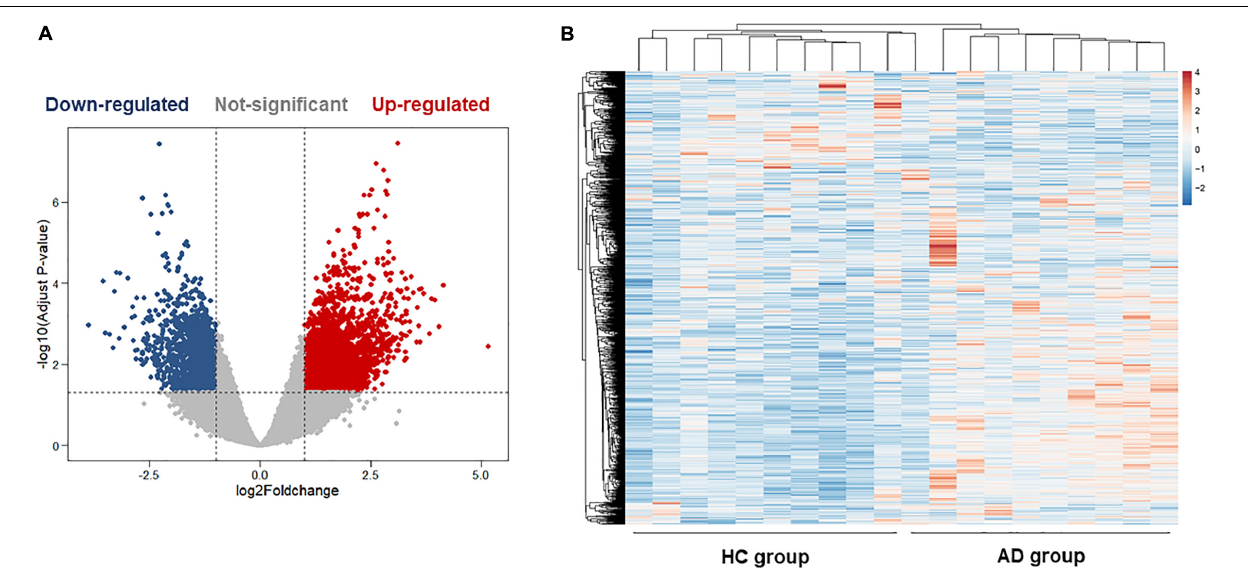
FIGURE 2 | Bioinformatics analysis of differentially expressed genes (DEGs) in the hippocampus of health control (HC) and Alzheimer’s disease (AD) patients. (A) The volcano plot of DEGs in the hippocampus between the HC group and the AD group. (B) Heatmaps of DEGs in the hippocampus of the HC group and the AD group. Colors in the heatmaps indicate the row Z-score among the different datasets. High expression is shown by the red color, and low expression is shown by the blue